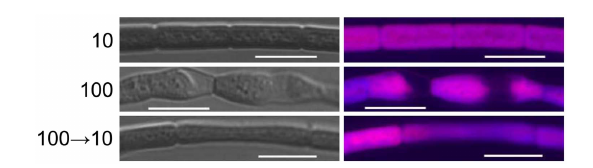
FIGURE 4 | Confocal laser scanning microscopy analyses of cellular morphology of Fremyella diplosiphon UTEX 481 wild-type (WT) strain transitioned from high intensity green light (GL) compared to low GL intensity. F. diplosiphon WT was grown in BG-11 culture medium containing 20mM HEPES at 100 μ molm − 2 s − 1 at 28˚C with shaking at ∼ 175rpm for > 25 dilutions and then moved to 10 μ molm − 2 s − 1 . Cells were imaged 3days after being moved to low GL, i.e., 100 → 10. Representative optical slices from a Z-series of differential interference contrast (DIC) images (left column) and maximum intensity projection of phycobiliprotein autofluorescence images (right column) ofWT. All images were acquired with a 40 × oil objective with 2 × zoom. Bar represents 10 μ